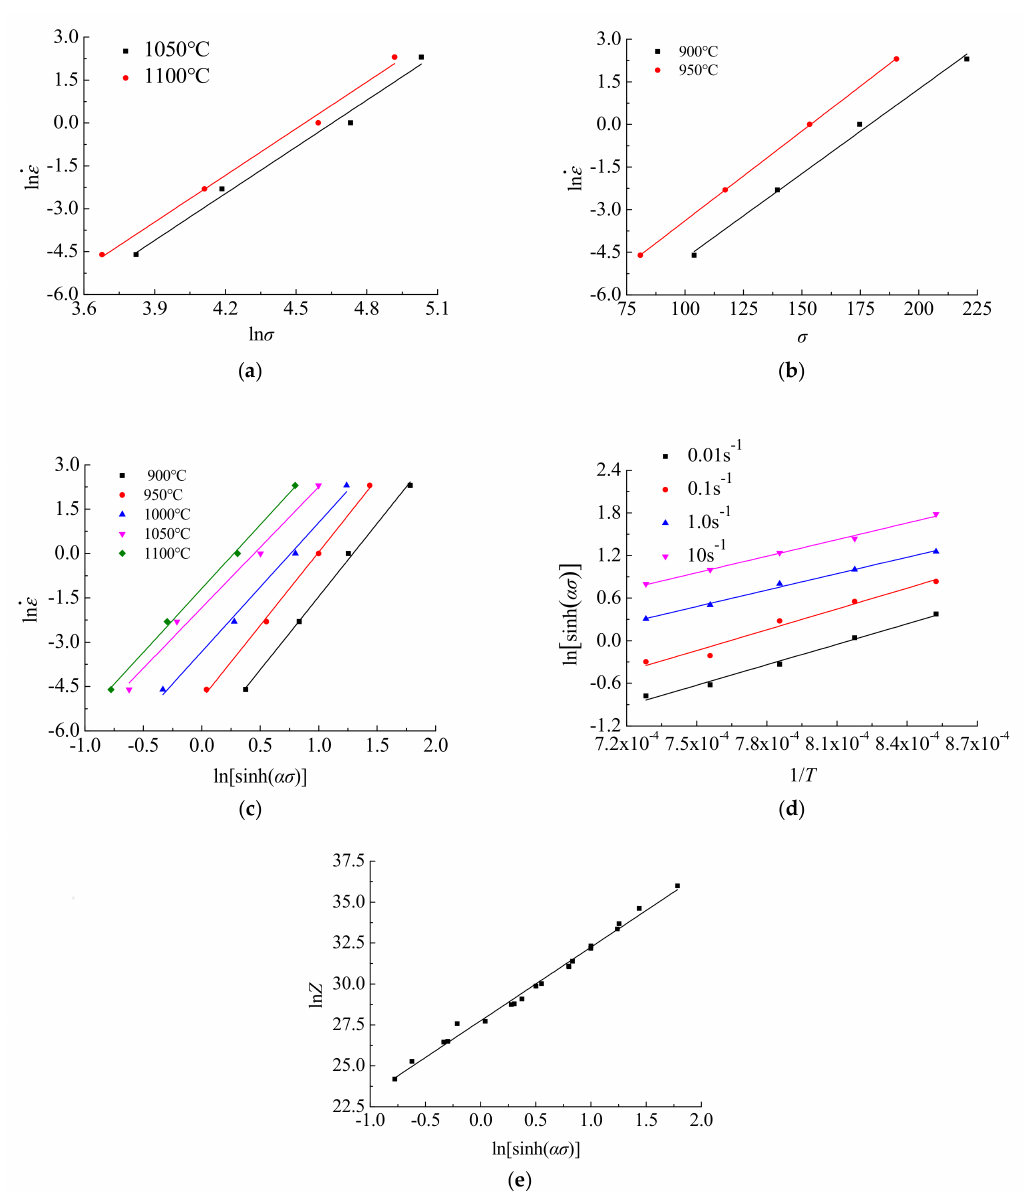
. ε . ε . ε -In σ ; ( b ) In - σ ; ( c ) In -In[sinh( ασ )]; ( d ) In[sinh( ασ )]-1 / T ;